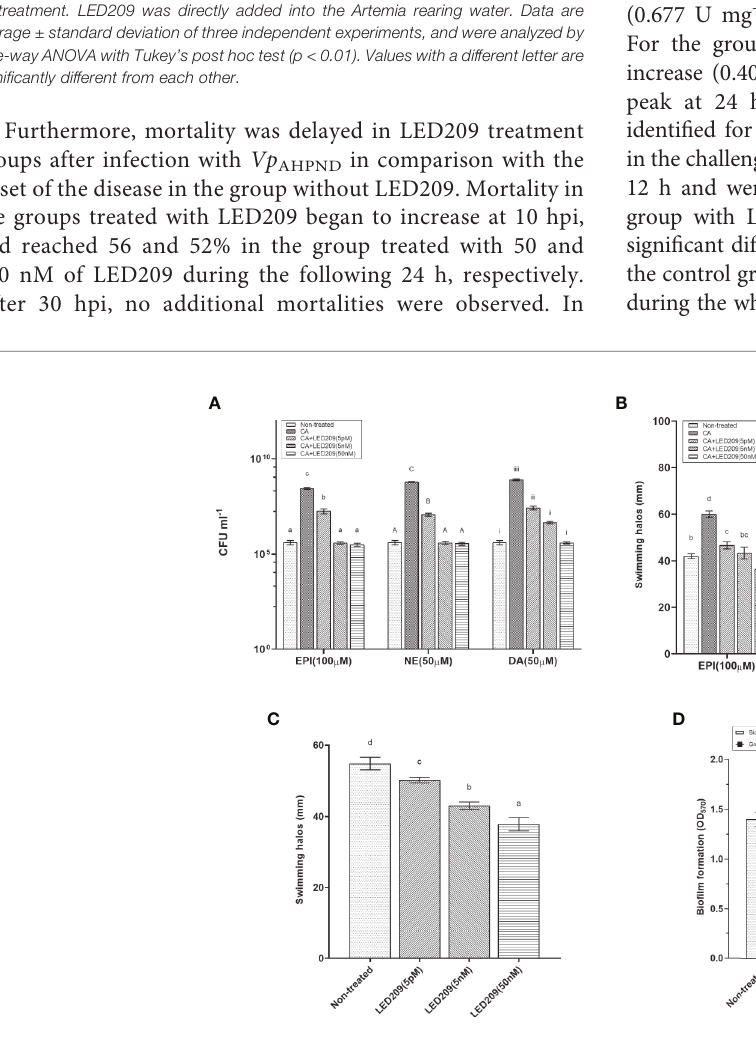
FIGURE 4 | LED209 neutralizes the catecholamine enhanced growth (A) and swimming motility (B) in Vp AHPND 123. Three kinds of catecholamine including Epinephrine (EPI), norepinephrine (NE), and dopamine (DA) were used at 100, 50, and 50 µM, respectively. (C) Treatment with LED209 diminished swimming motility of Vp AHPND 123. Diameters of motility halos after 18 h of incubation on TSA30 plates containing 0.3% agar were measured in the presence (5 pM, 5 nM, and 50 nM, respectively) or absence (DMSO only) of LED209. (D) Administration of LED209 reduced bio fi lm formation of Vp AHPND 123. Strain was grown statically in TSB30 in 96-well plate for 24 h in the presence (5 pM, 5 nM, and 50 nM, respectively) or absence (DMSO only) of LED209. Bio fi lm formation was determined by measuring crystal violet binding at OD 570 . The error bars represented standard deviation (SD) of three independent experiments. Different letters indicate signi fi cant differences (One-way ANOVA with Tukey ’ s post hoc test; p < 0.01).